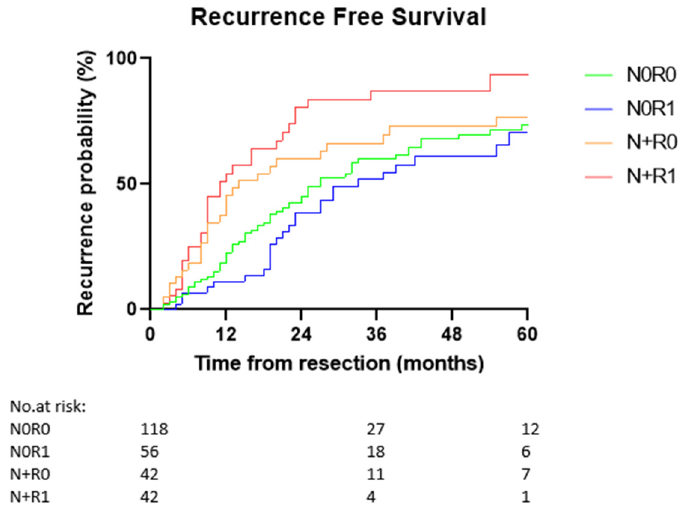
Figure 3). The comparison per status was: N0R0 vs. N+R0: p = 0.151, N0R1 vs. N+R1: p <